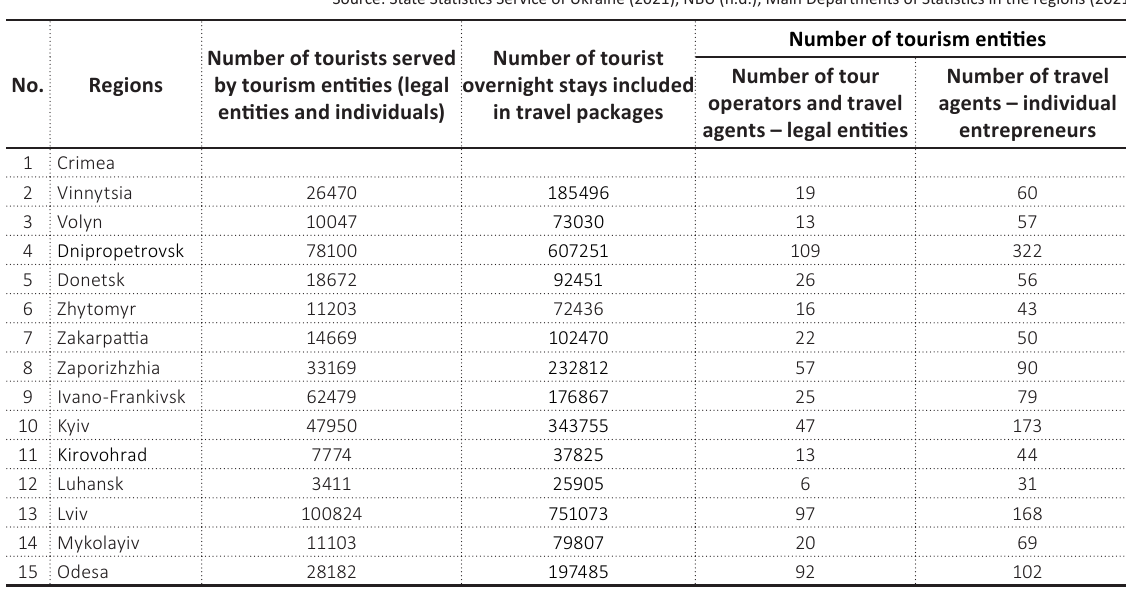
Table E1. Indicators of demand and supply of tourist services in Ukraine’s regions in